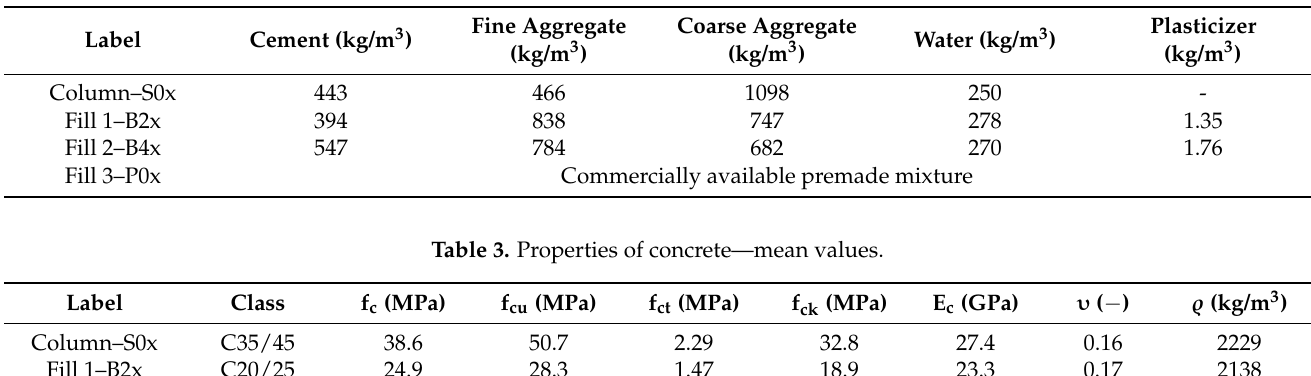
Table 2. Composition of concrete mixture.